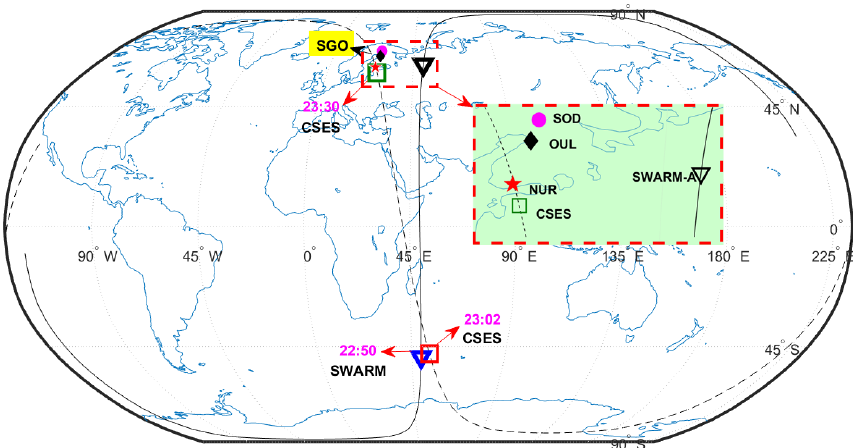
Figure 2. The locations of Pc1 waves observed by the CSES (squares) and Swarm (triangles) satellites. The red star, black diamond, and pink dot represent the following three SGO stations: Nurmijärvi (NUR – L = 3 . 4, 57.1 ◦ N, 101.2 ◦ E, QD); Oulu (OUL – L = 4 . 5, 61.9 ◦ N, 104.1 ◦ E, QD); and Sodankylä (SOD – L = 5 . 3, 64.3 ◦ N, 105.6 ◦ E, QD), respectively. The broken and solid black lines denote the trajectories of the CSES and Swarm-A satellites, respectively, and the red arrows represent three Pc1 wave observations.